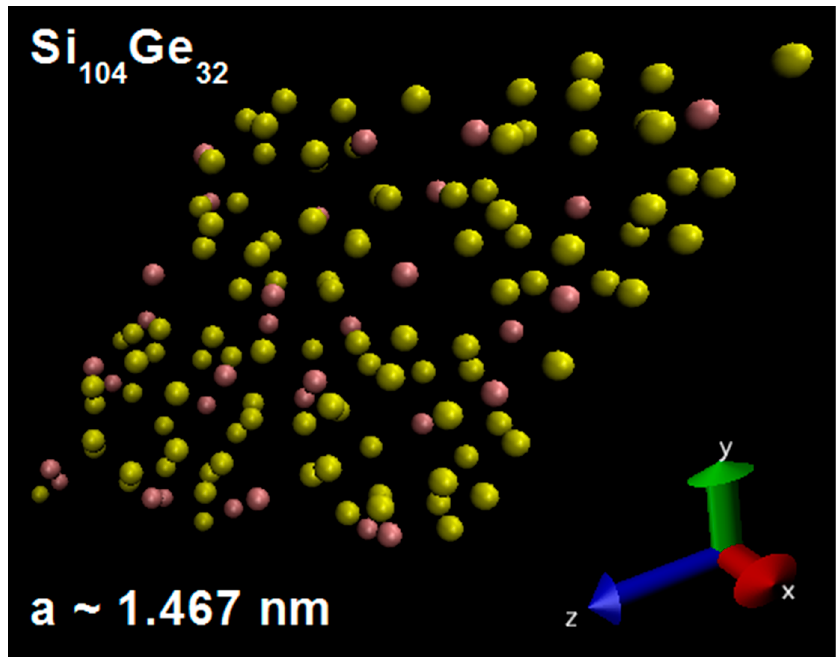
Figure 1. Cubic unit cell of Si 104 Ge 32 . The yellow solid balls denote the Si atoms while the purple solid ones represent the Ge atoms that act as substitutional framework hosts.